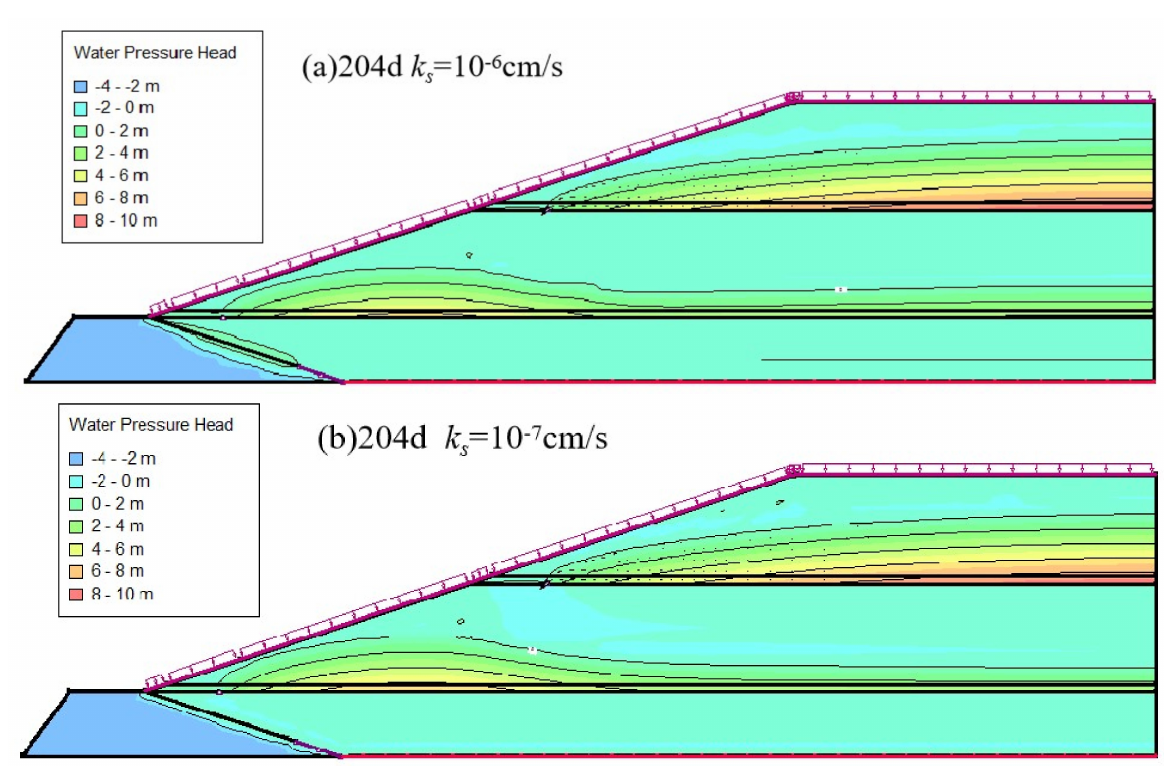
Figure 7. Leachate distribution during rainstorm (intermediate cover k s = ( a ) 10 − 6 cm/s; ( b ) 10 − 7